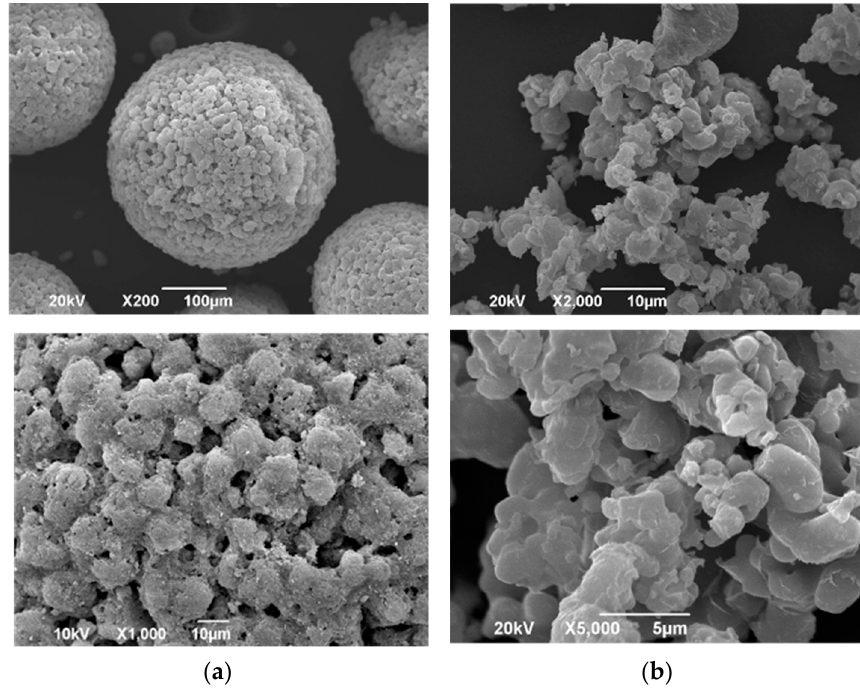
Figure 1. SEM images of PS300 and CaSiO 3 . ( a ) PS300; ( b ) CaSiO 3 .